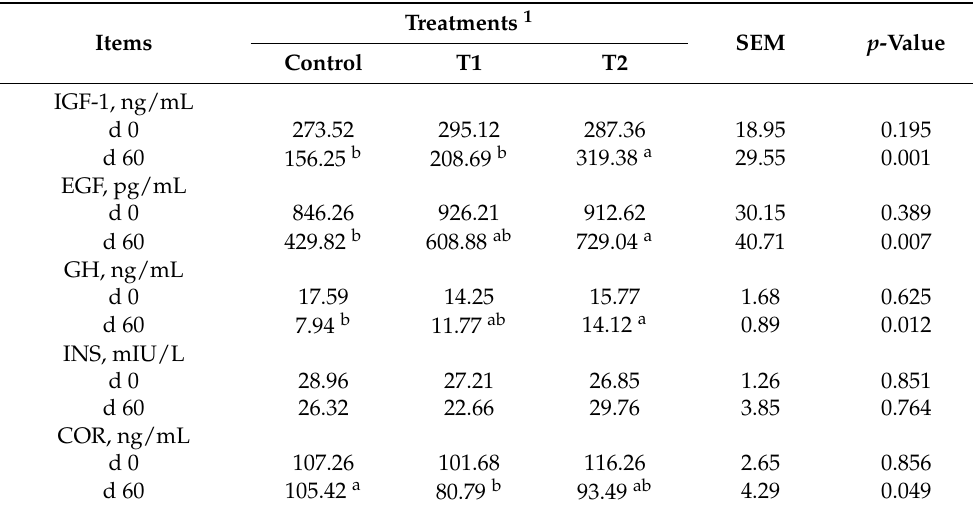
Table 5. Effect of Bacillus licheniformis and the combination of probiotics and enzymes on serum hormone of yak